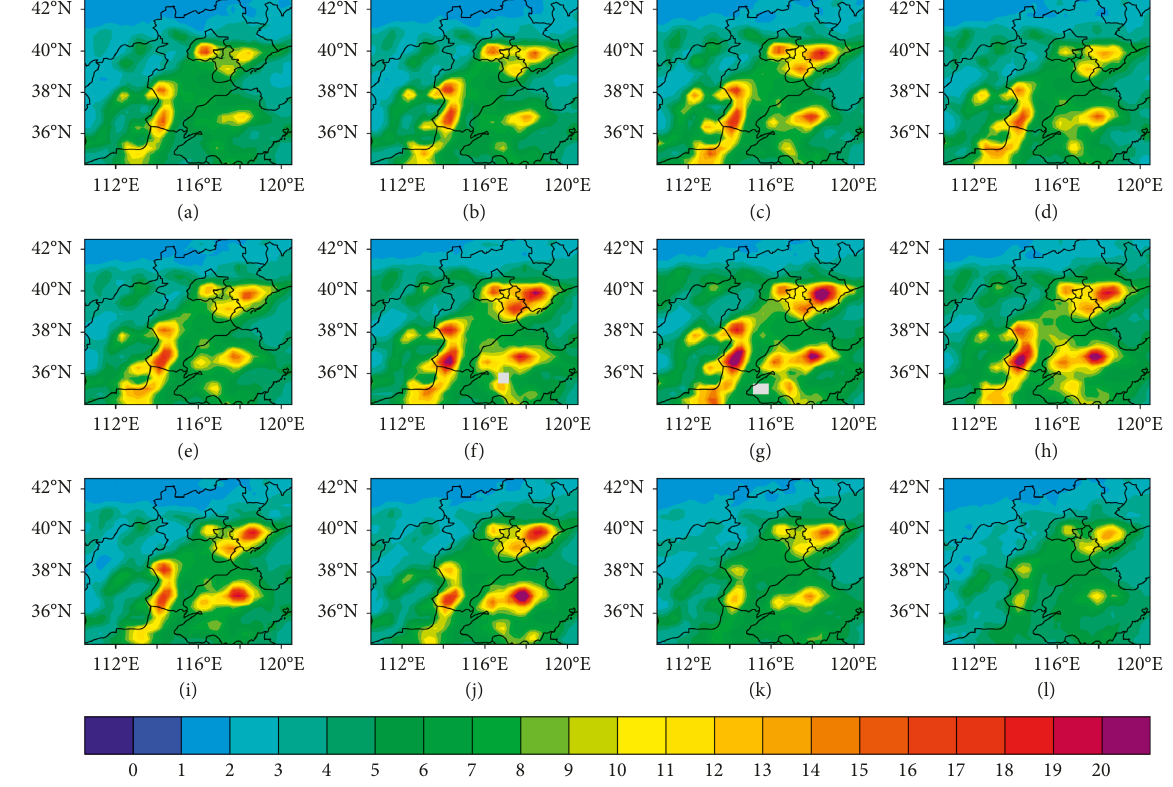
15 molec cm − 2 ): (a) 2005, ·